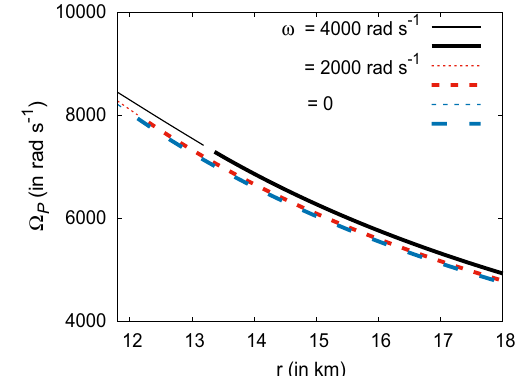
Fig. 15 Effect of the angular velocity of the star on Ω P of a gyro moving in a stable circular geodesic around a 1 . 5 M ◦ NS. The central energy density is taken to be 7 . 4 × 10 14 g cm − 3 . The solid black line, red short dashed line, and blue dashed line are for ω = 4000 rad s − 1 , 2000 rad s − 1 , 0 rad s − 1 respectively. The thicker line indicates exterior region. Here Ω is equal to Ω g